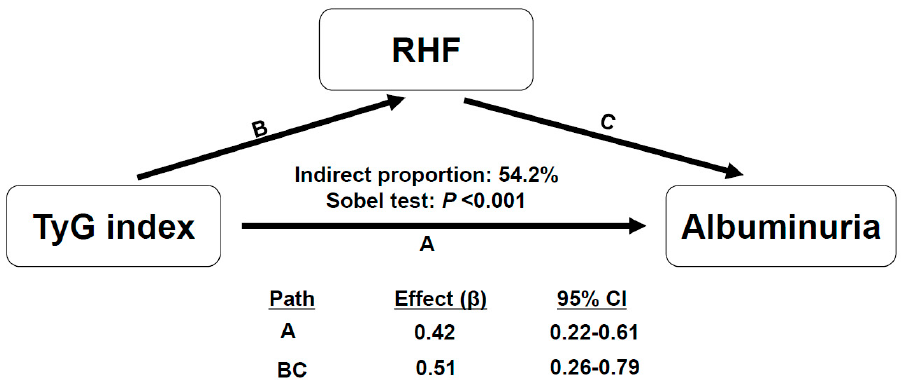
Figure 4. Mediation analysis of the association between TyG index and albuminuria mediated by RHF. Path effect is reported as the estimated regression coefficients ( β ). Residual direct effect is labeled as path A and indirect effects are labeled with relevant groups of path BC. Analyses are adjusted for age; sex; smoking and alcohol status; education and income levels; BMI; SBP; hemoglo-